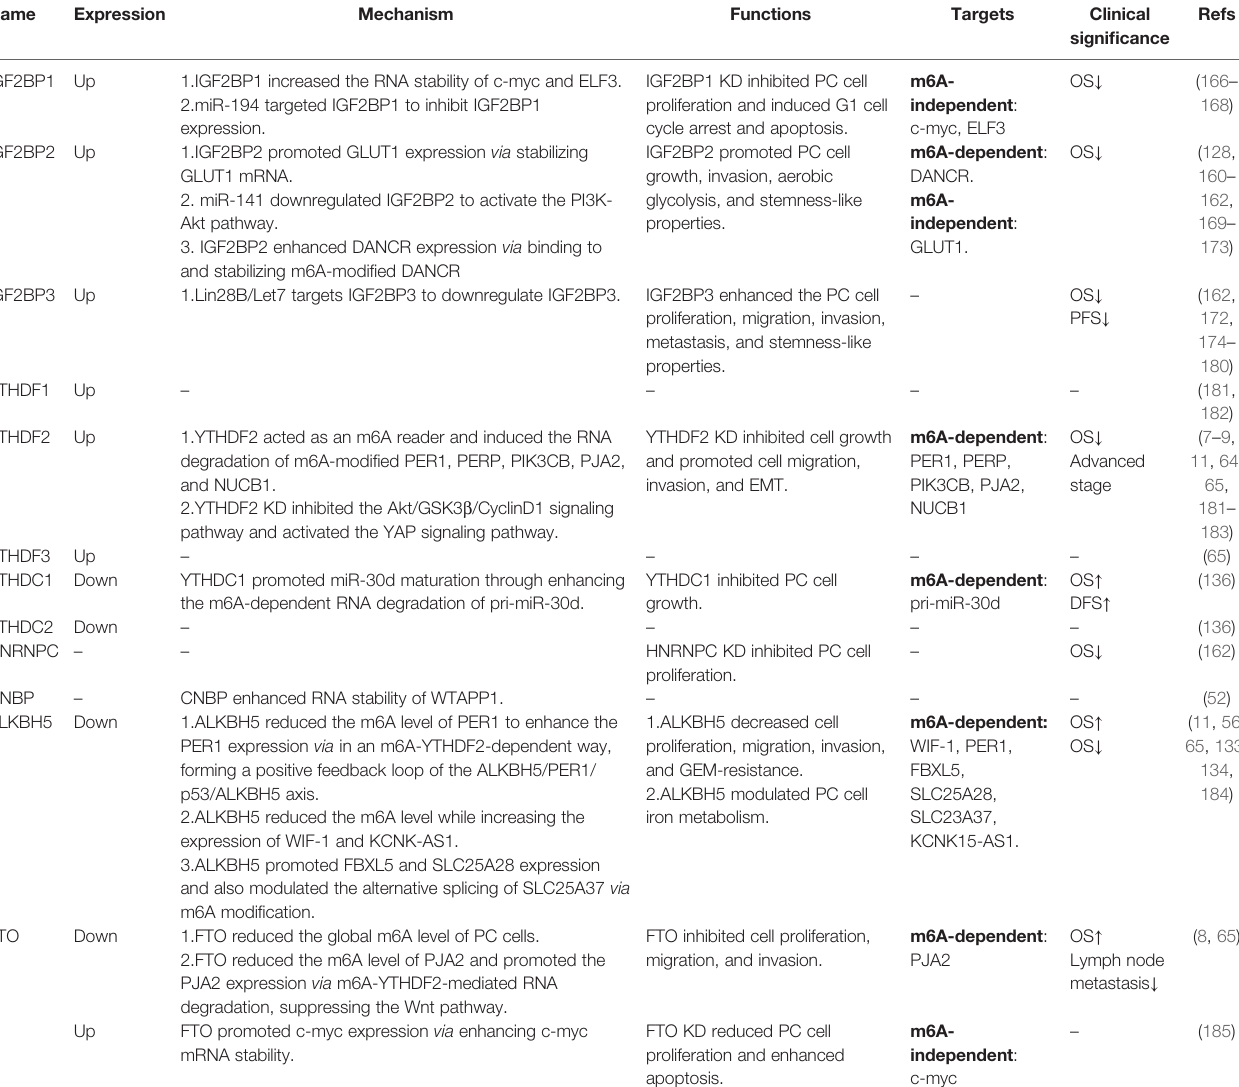
TABLE 4 | Functions of m6A readers and erasers in pancreatic